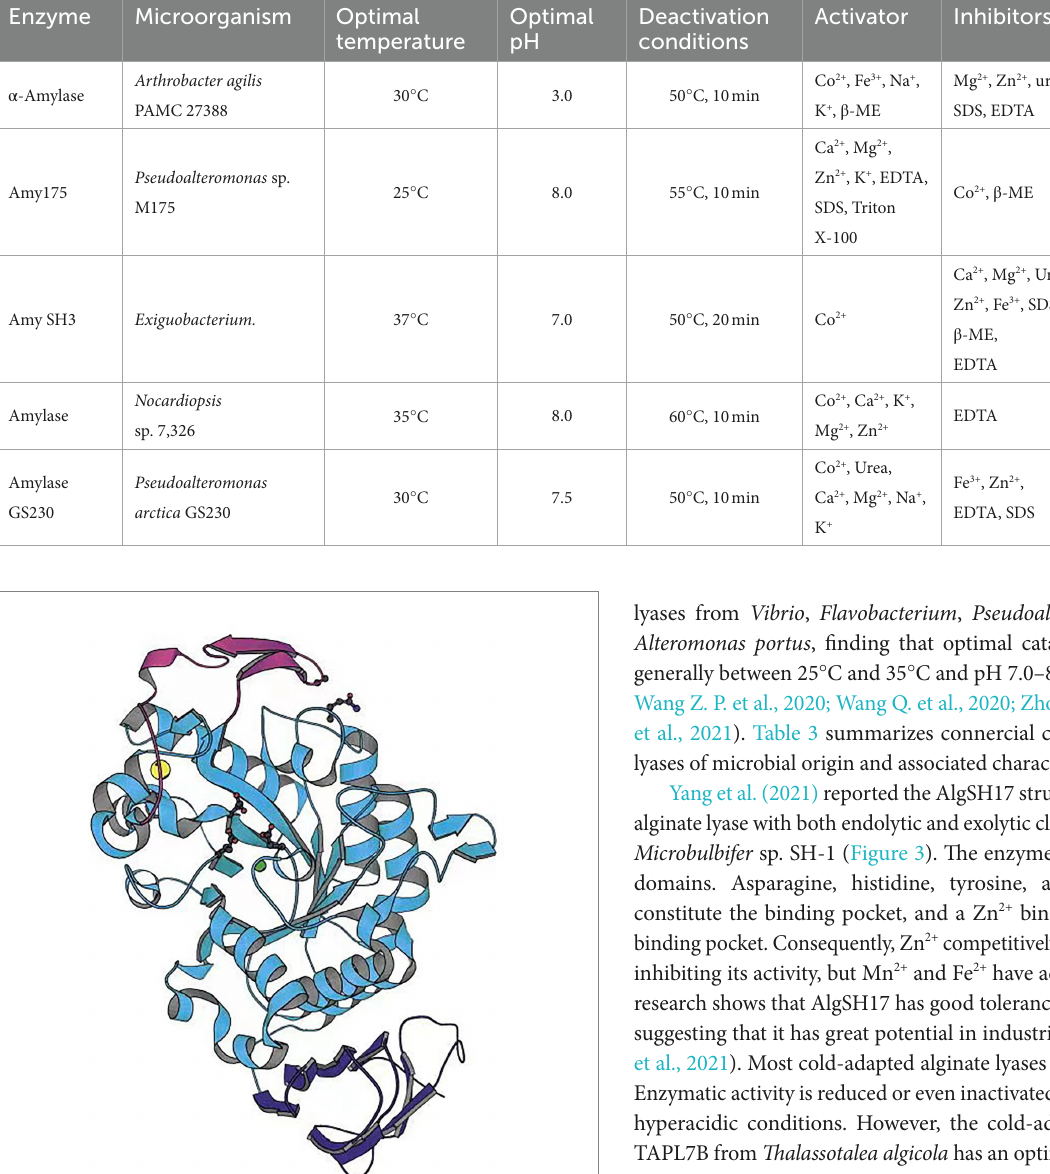
TABLE 1 Cold-adapted α -amylases from various microorganisms and associated characteristics. Enzyme